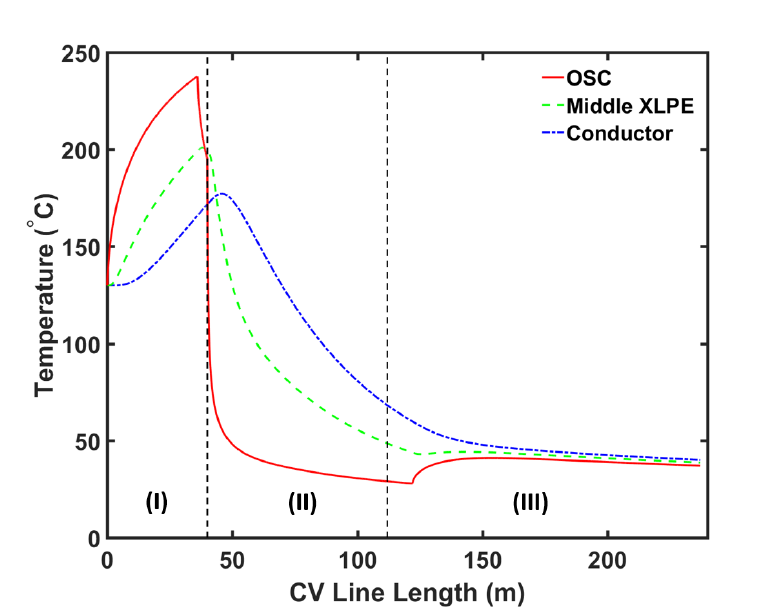
Figure 6. CV line temperature profile at different distances from the cable centre. Segment (I), (II) and (III) correspond to the curing tube and transition zone, water-cooling, and air-cooling segments,